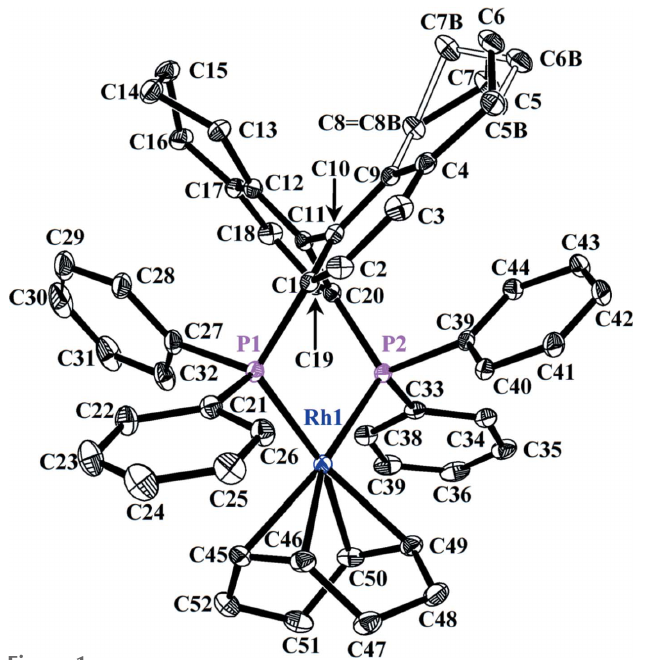
A view of the [Rh(H 8 -BINAP)(cod)] + cation, with the atom-labelling scheme. Displacement ellipsoids are drawn at the 30% probability level and H atoms have been omitted for